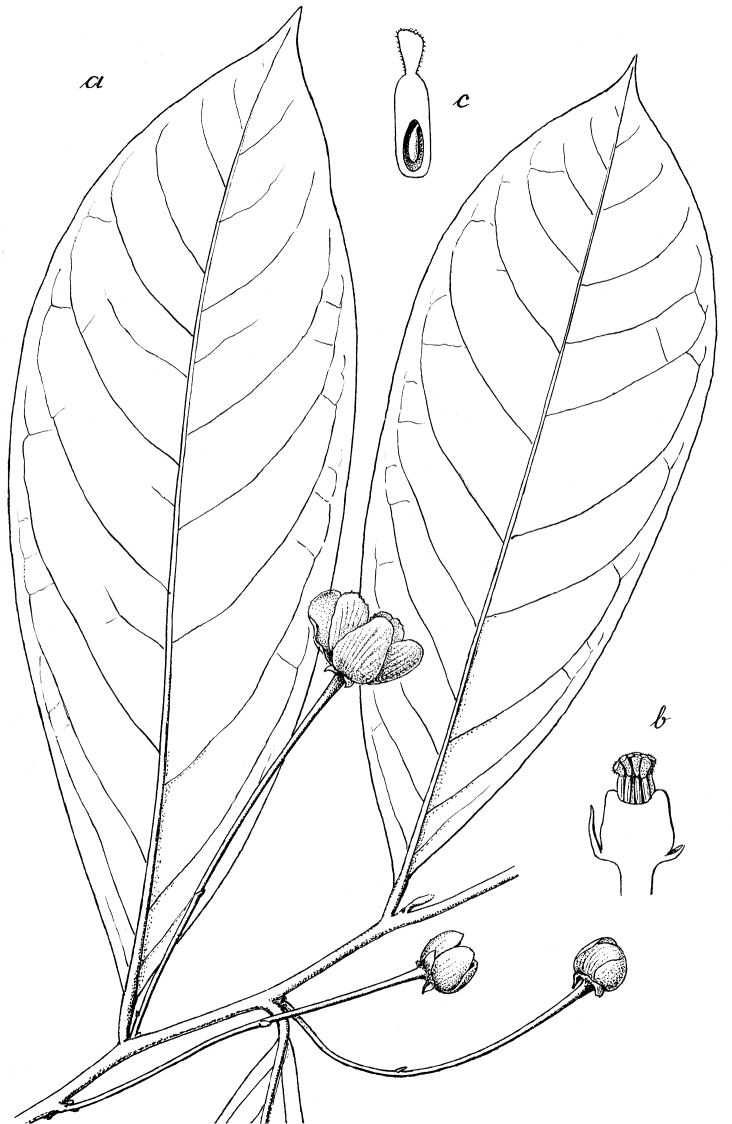
Cremastospermapedunculatum (Diels) R.E.Fr. a flowering twig b receptacle, illustrating insertion of carpels c carpel with single apical/lateral ovule (a–cWeberbauer 4558, reproduced from Fries (1930).